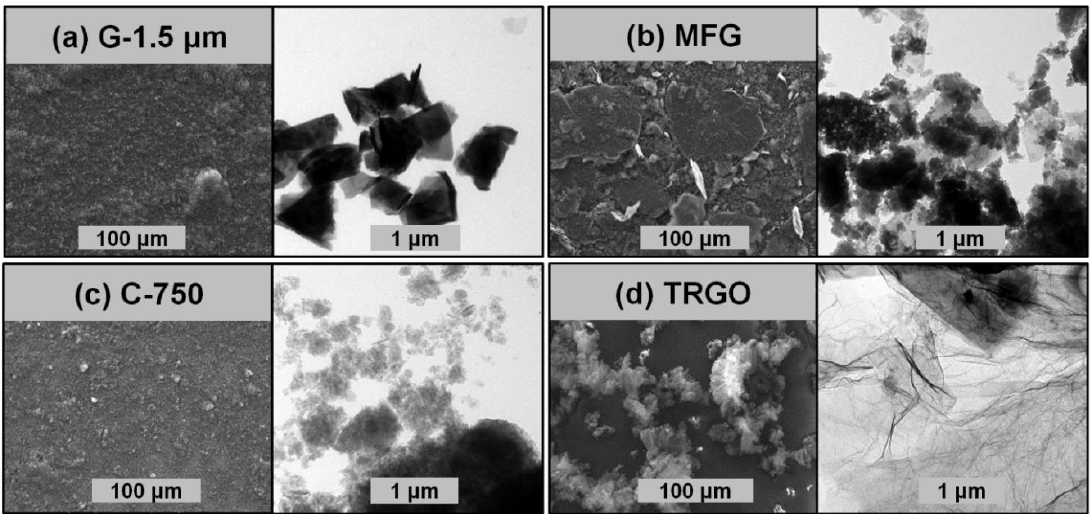
Figure 2. Morphology, as determined by SEM (1st and 3rd column) and TEM (2nd and 4th column), of G-1.5 µm ( a ), MFG ( b ), C-750 ( c ), and TRGO ( d ).